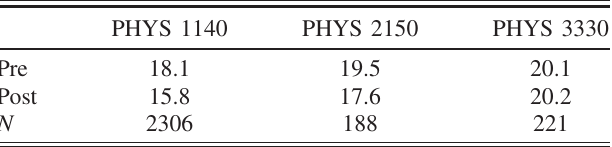
TABLE III. Pseudolongitudinal E-CLASS averages (max